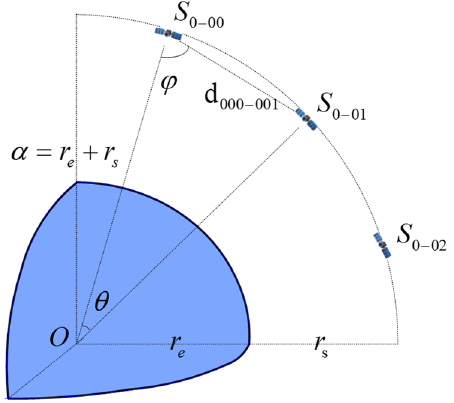
Table 3. Keplerian elements of the Iridium constellation.